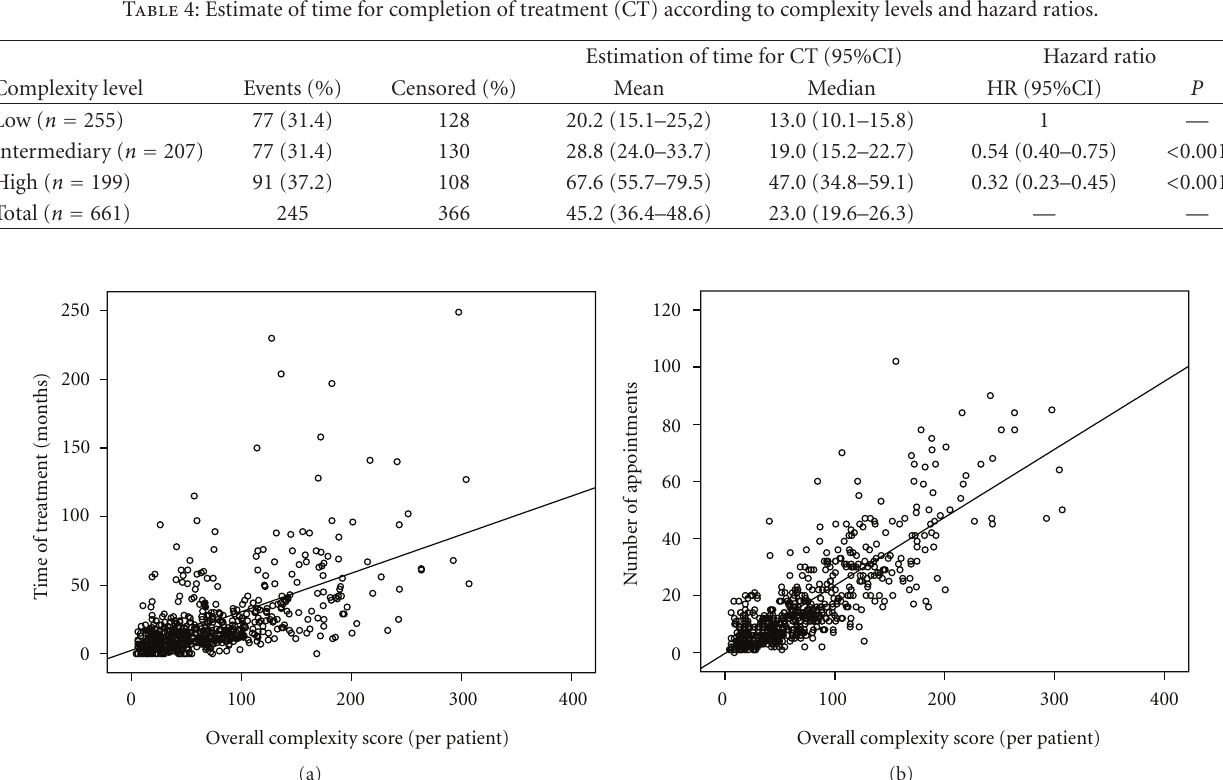
Table 4: Estimate of time for completion of treatment (CT) according to complexity levels and hazard ratios.